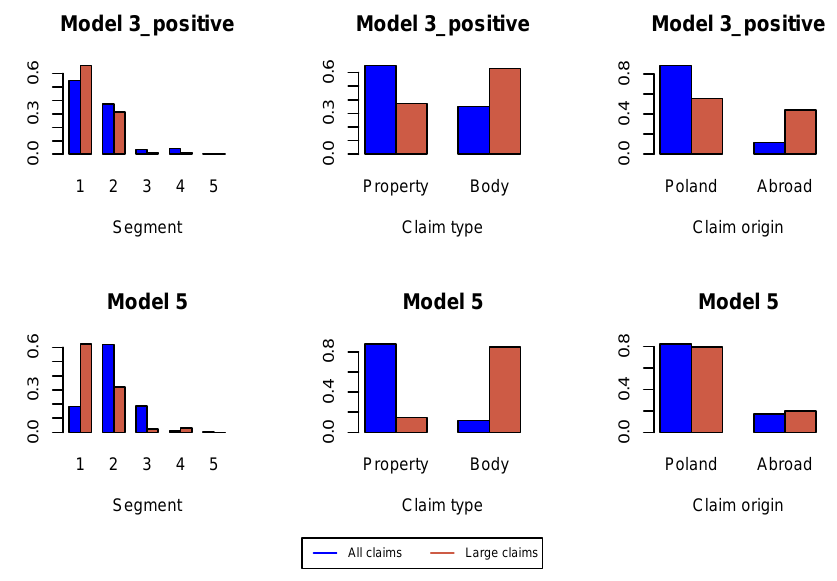
Figure A6. Proportions of claim features in the whole data set and in the data set of large claims in k = 8.